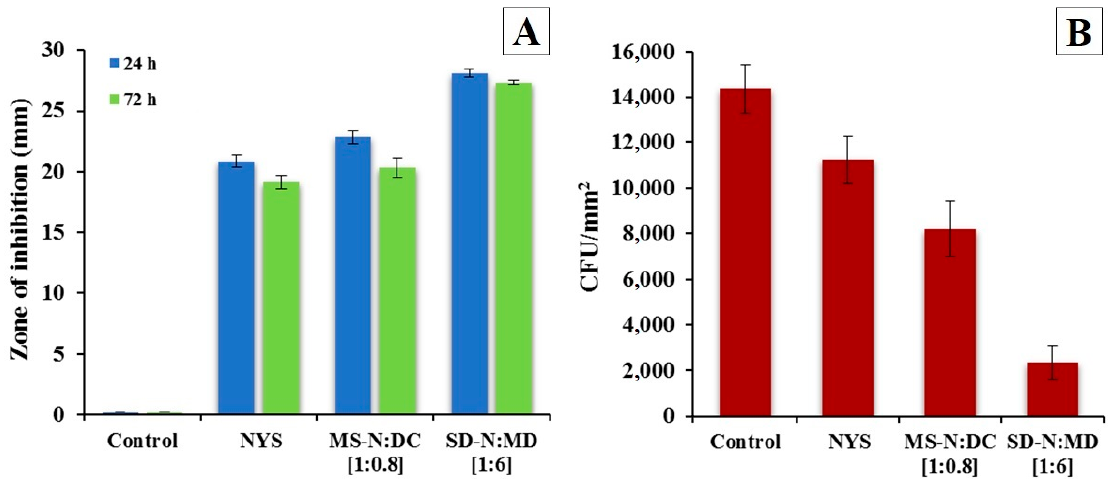
Figure 6. Effects of different formulations on Candida albicans . ( A ) Halo zone for fungal inhibition (mm) after 24 and 72 h. ( B ) Candida albicans adherence on plastic discs. Adherence is expressed as the number of colony-forming units per mm 2 after incubation for 48 h. Formulations: control = nystatin raw material (NYS), nystatin micellar system MS-N:DC [1:0.8], and solid dispersion SD-N:MD